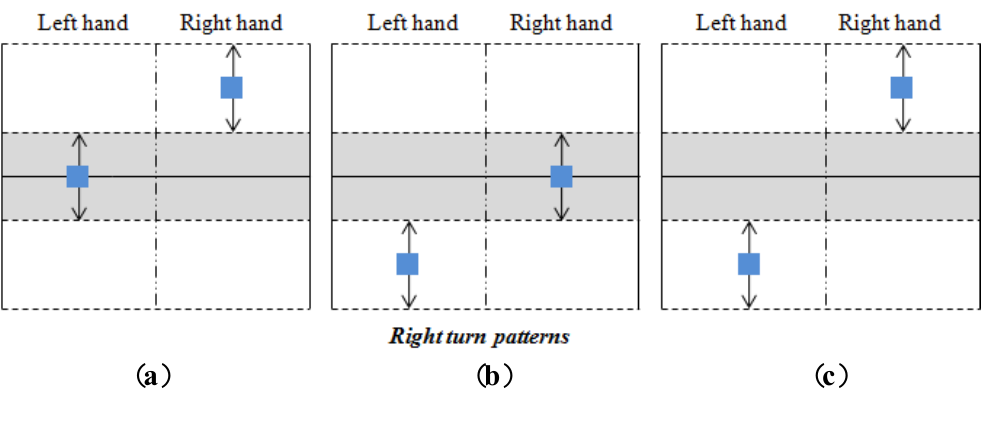
Figure 14. Right turn